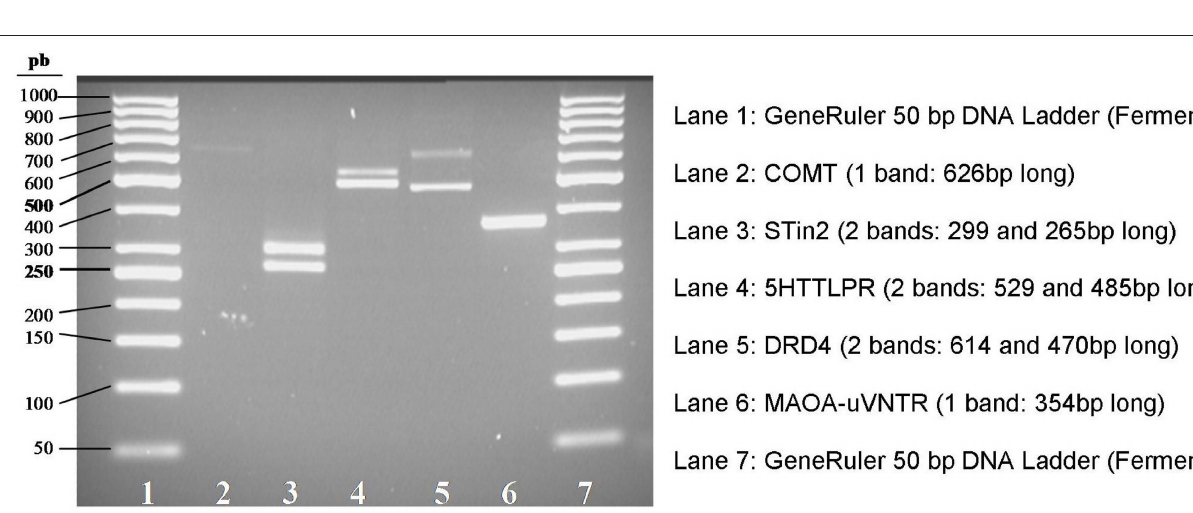
FIguRe 3 | electrophoretic patterns of PCR products obtained from J.F.’s DNa. STin2, 5HTTLPR, DRD4 (lanes 3, 4, and 5) show two bands with different molecular weights, each corresponding to a different allele (heterozygous